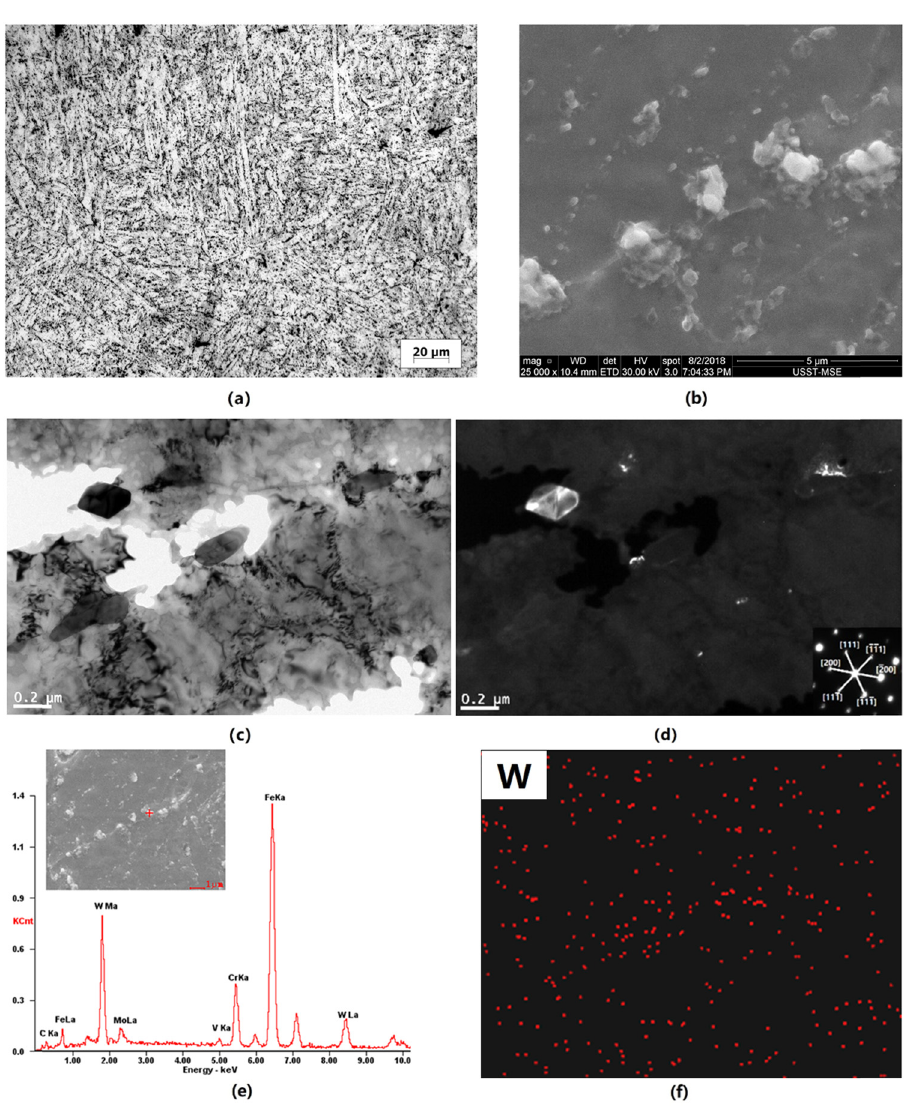
Figure 4: ( a ) OM image, ( b ) SEM image, ( c ) TEM bright - fi eld image, ( d ) TEM dark - fi eld image and SAED of M 23 C 6 , ( e ) SEM – EDS result of P92 steel after 650°C – 7,000 h aging, and ( f ) SEM – EDS mapping image of W in P92 steel after 650°C – 7,000 h